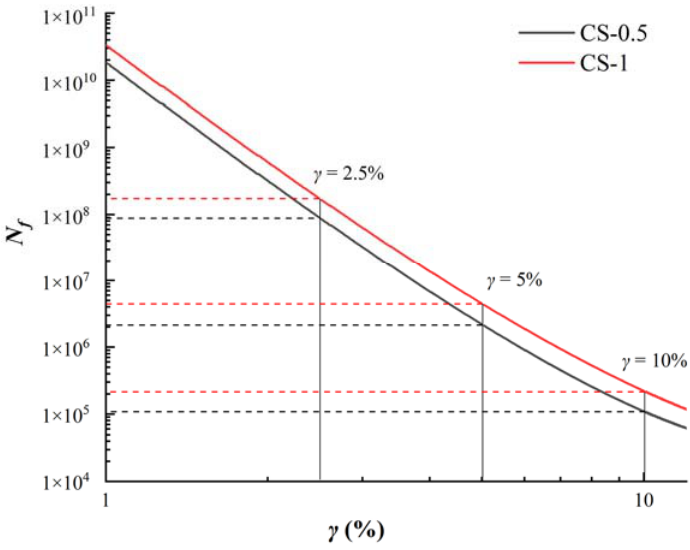
Figure 12. The fatigue life of sealants under different strains.